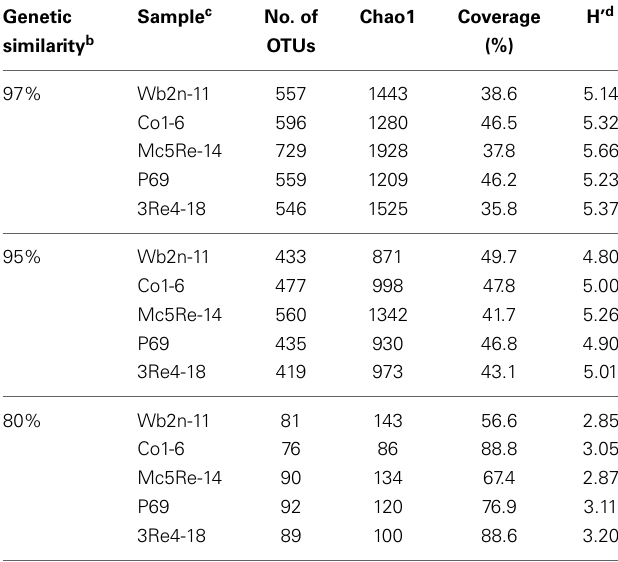
Table 1 | Richness estimates and diversity indices for amplicon libraries of rhizosphere samples a